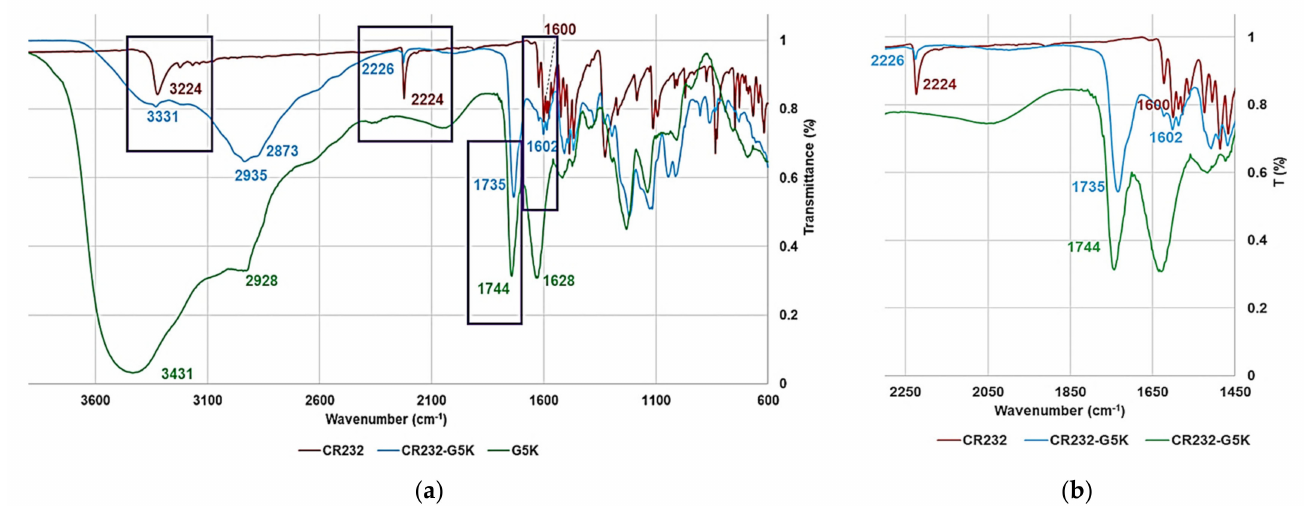
Figure 6. ATR-FTIR spectra of G5K (green line), CR232 (red line), and CR232-G5K (light blue line) ( a ); magnification of a significant spectral region ( b